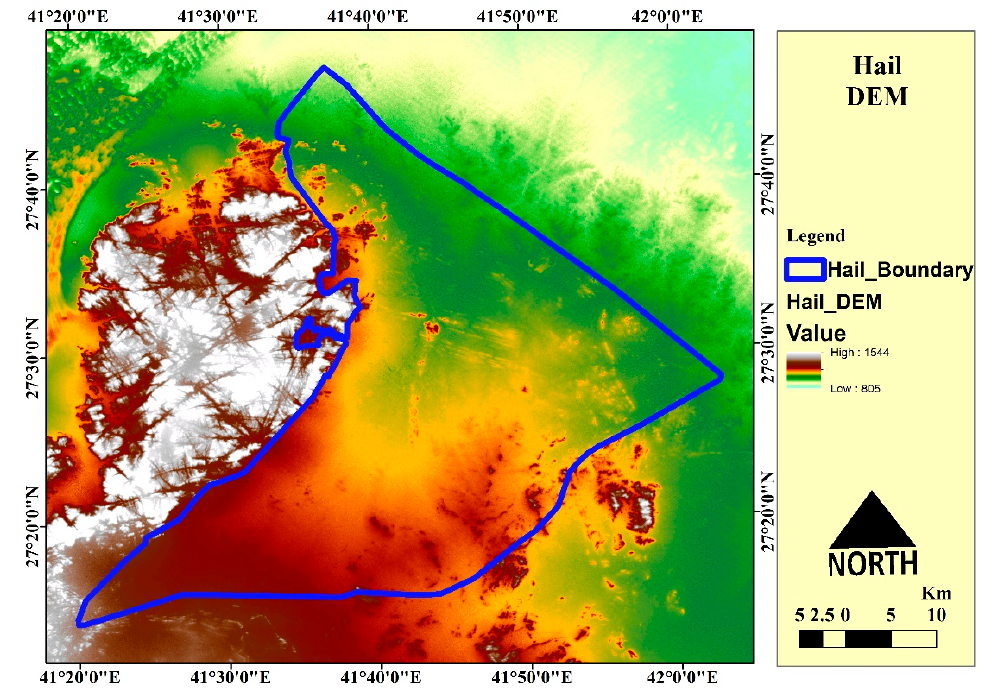
Figure 2. Digital Elevation Model file for the case study area.